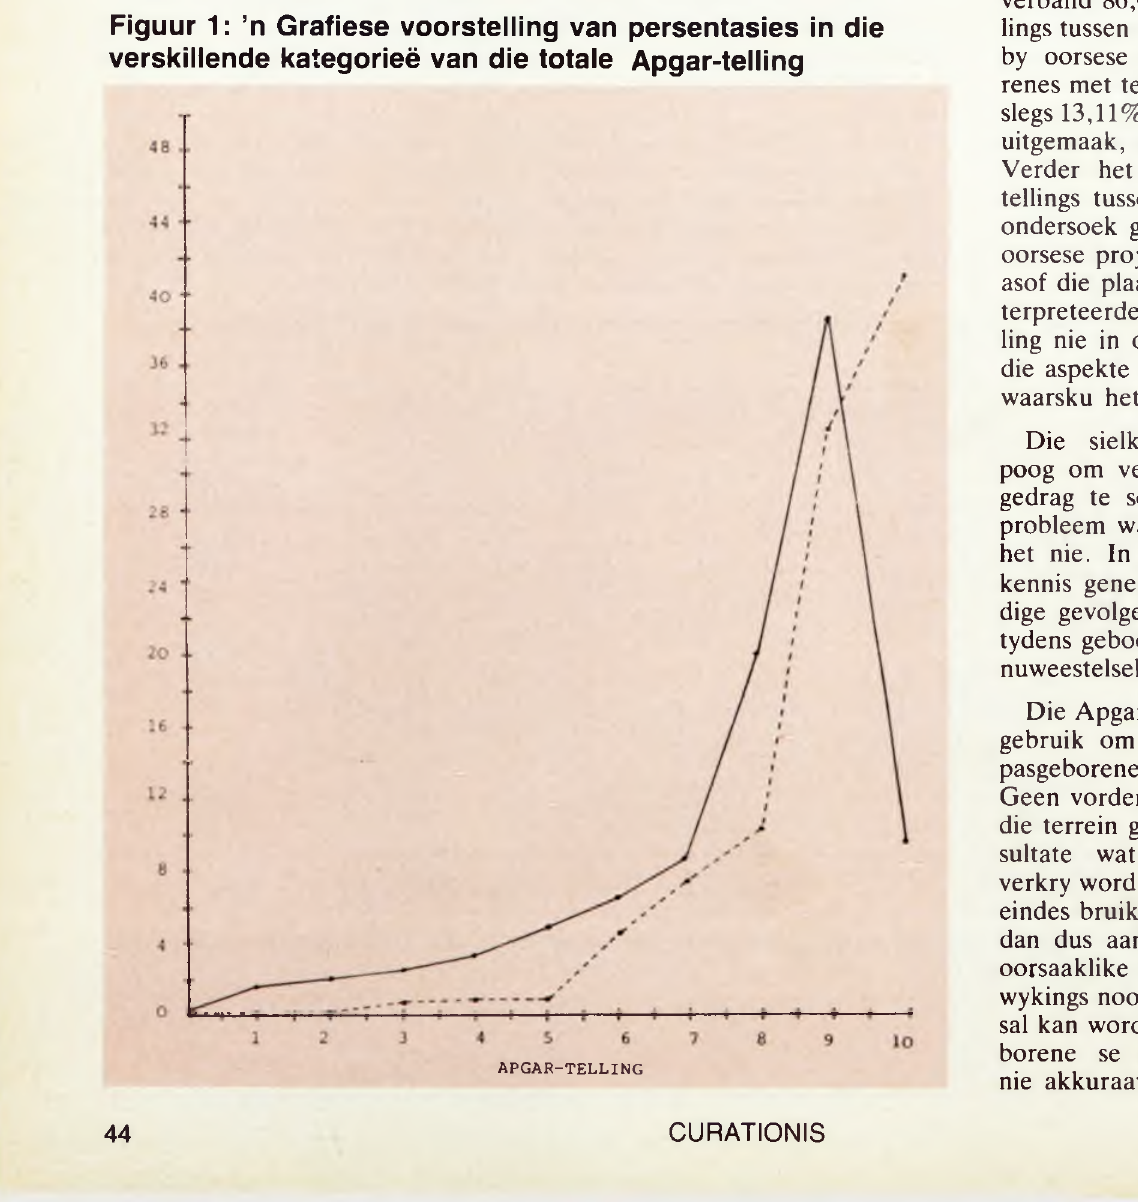
Figuur 1: ’n Grafiese voorstelling van persentasies in die verskillende kategorieë van die totale